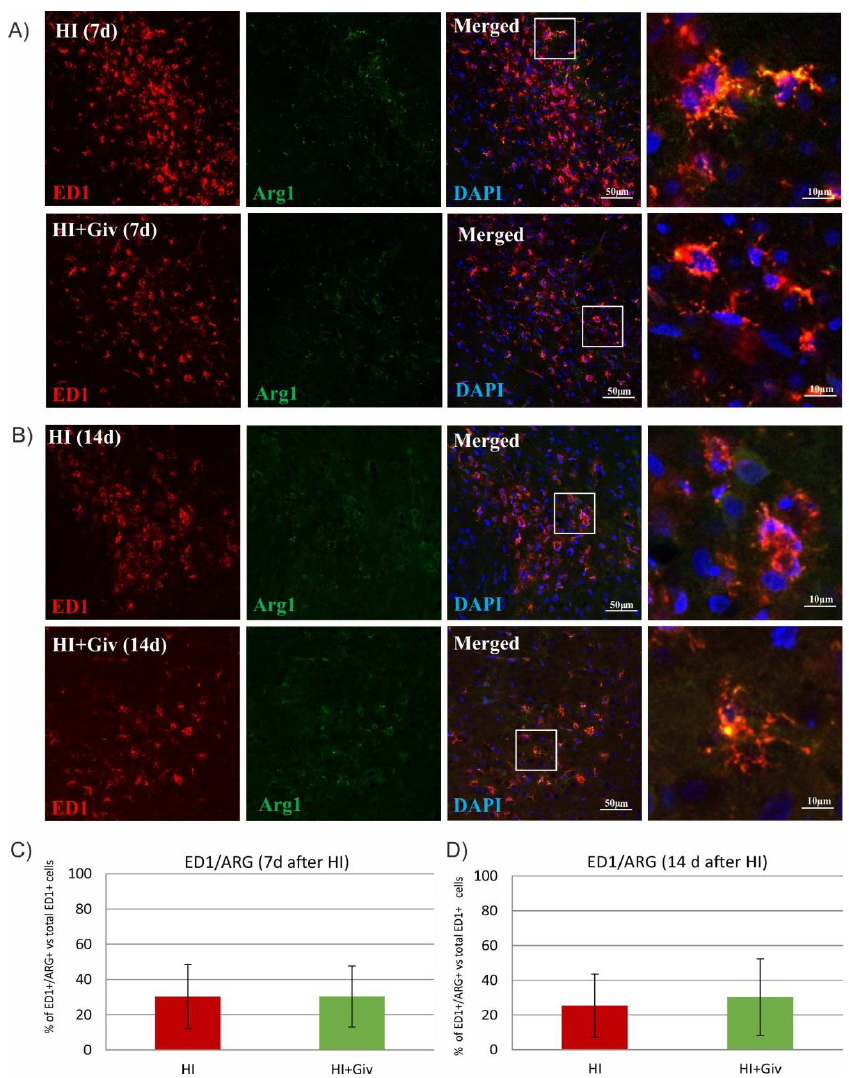
Figure 5. Givinostat has no effect on the polarization of microglia after neonatal hypoxia-ischemia. Sections from ipsilateral (hypoxic-ischemic) hemispheres 7 and 14 days after HI were stained for anti-ED1 antibody-labeled reactive phagocytic microglia (red) and arginase-1 (Arg-1), a marker specific for the M2 phenotype (green). Nuclei were labeled with DAPI (blue). Representative photomicrographs of brain sections show double-labeled cells (yellow) 7 days ( A ) and 14 days ( B ) after HI. Enlargements present areas marked in rectangles. Number of ED1/Arg-1-positive cells quantified in the brain cortex area (0.36 mm 2 ) 7 days ( C ) and 14 days ( D ) after HI. The values are means ± SD from five animals per group. One-way ANOVA and Tukey’s test did not indicate any significant differences between the investigated